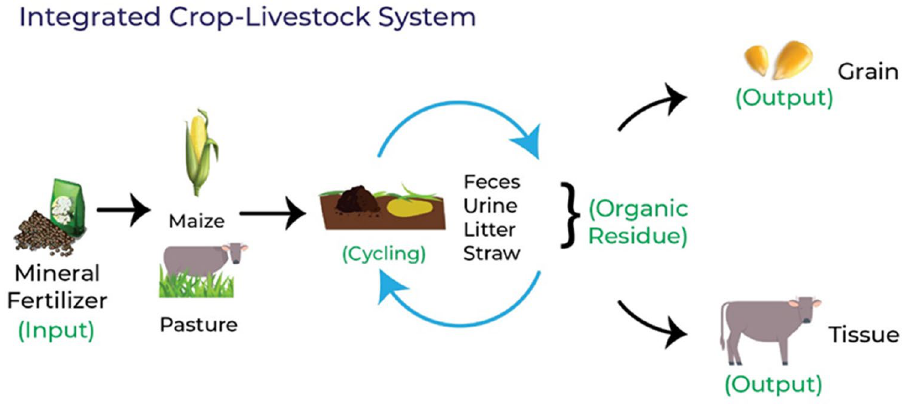
Figure 5. Representation of inputs and outputs of nitrogen and organic residues generated in the integrated